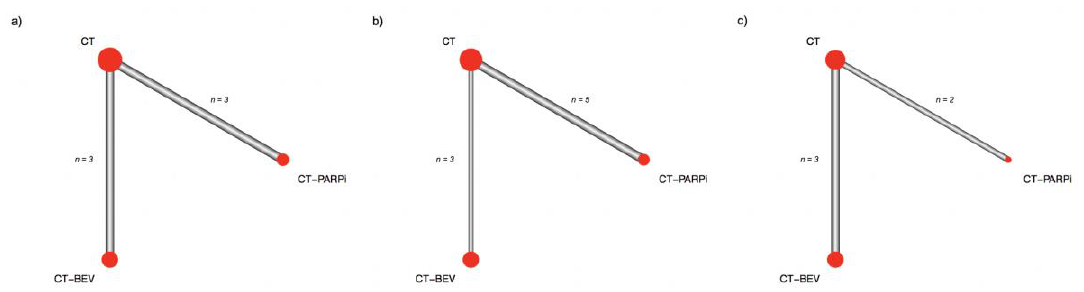
Figure 1. Network geometry. Edges thickness is proportional to the number of direct treatment comparisons. Node size is proportional to the number of patients considered for a given treatment. ( a ) All comer population; ( b ) BRCA mutated patients; ( c ) BRCA wild type patients. Table 2. SUCRA values by different treatments in BRCAwt patients.